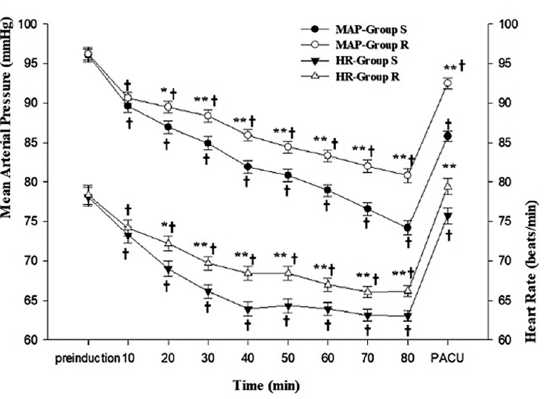
Figure 3. Mean arterial pressure and heart rate changes. PACU, post-anesthesia care unit. Data are presented as estimated mean ± SE. * p < 0.05 vs. group S, ** p < 0.01 vs. group S, † p < 0.01 vs. pre-induction. Table 3. The association between the severity of PS and the incidence of hypothermia in the PACU. No Hypothermia